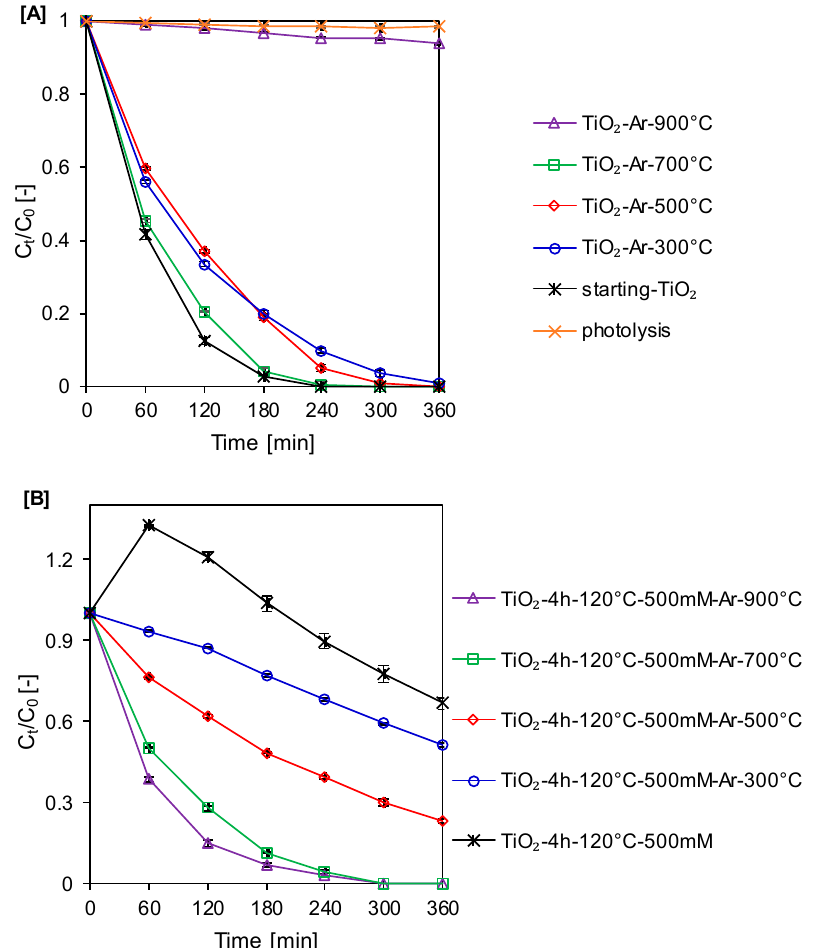
Figure 7. Methylene blue decomposition under UV irradiation for starting TiO 2 and calcined ref- erence samples ( A ), and APTES-modified TiO 2 before and after calcination ( B ).